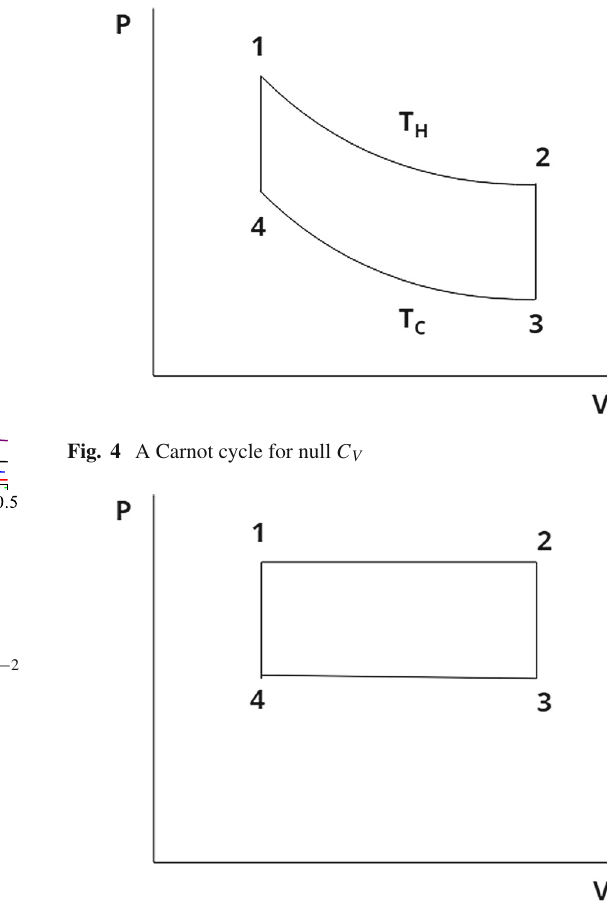
Fig. 5 A square cycle in the P–V